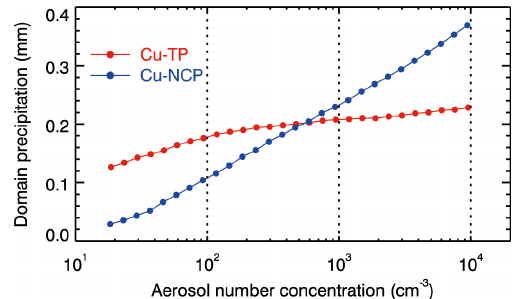
Figure 7. Modeled cumulative precipitation inside the model do-